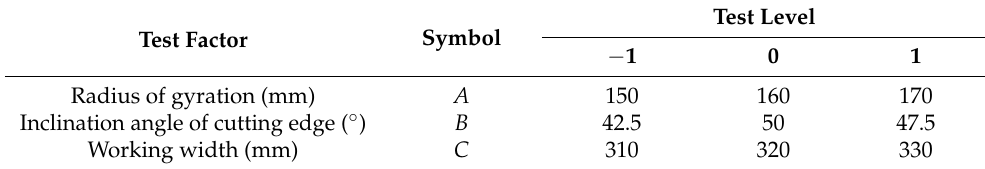
Table 5. Test factor codes.